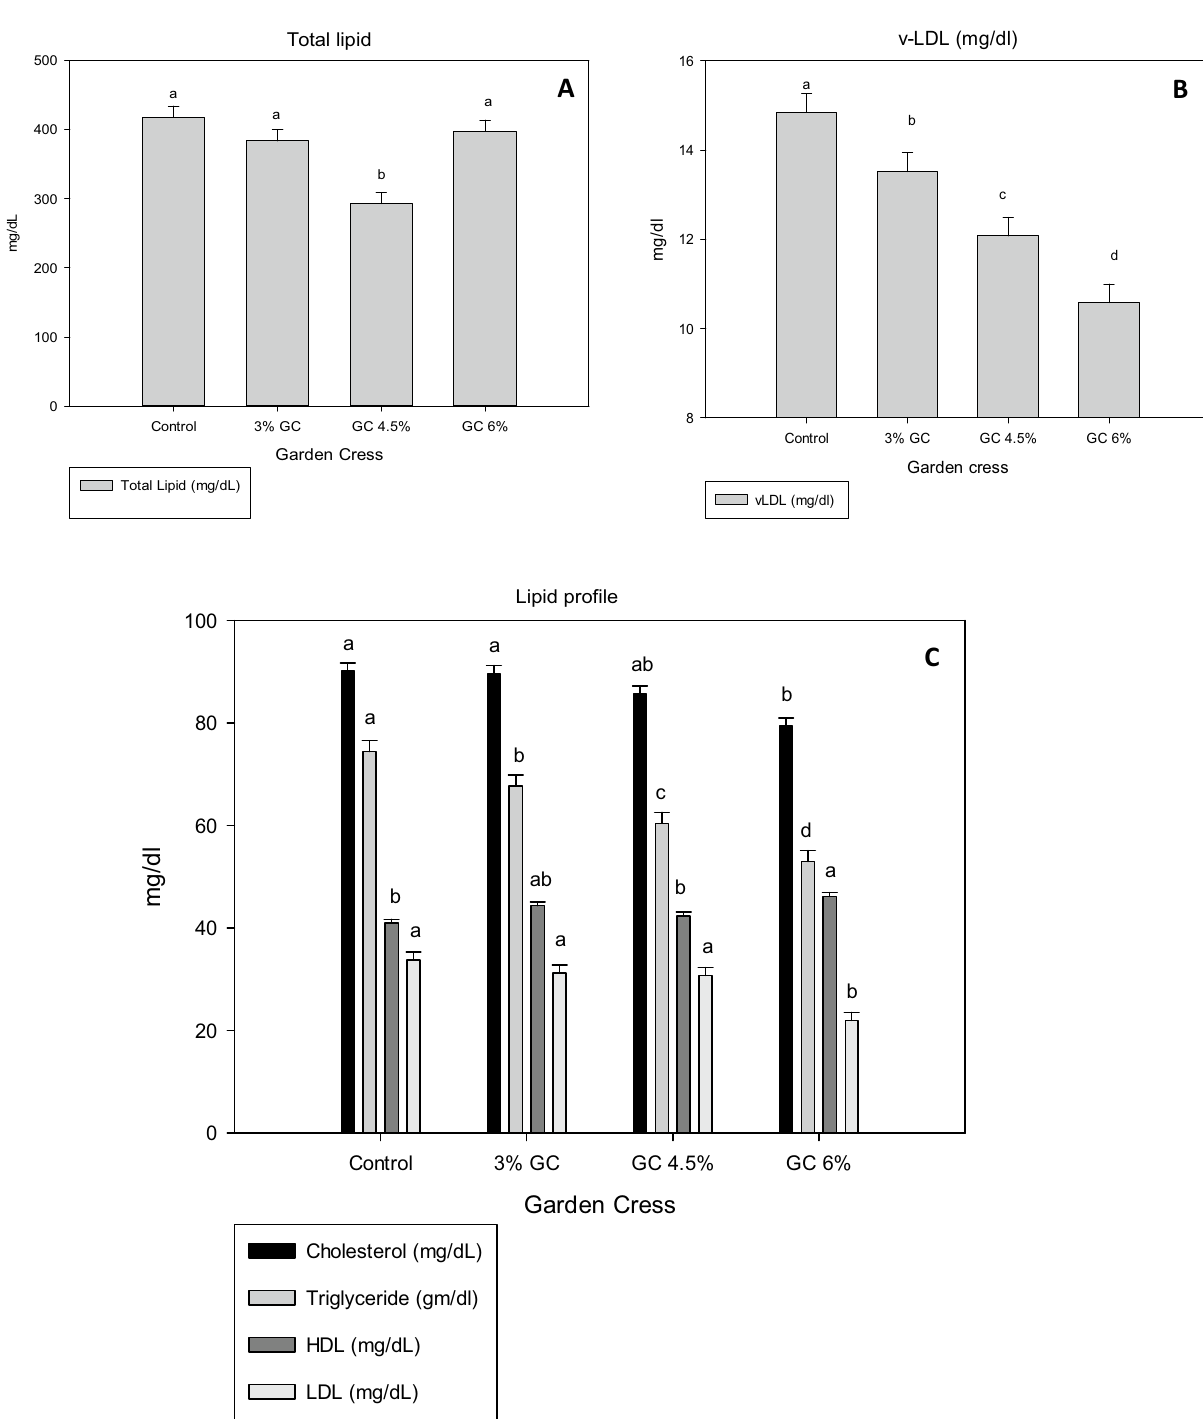
Figure 2. Effect of dietary levels of garden cress seeds on serum lipid profile ( A total lipid; B v-LDL and C cholesterol, triglyceride, HDL and LDL) of doe